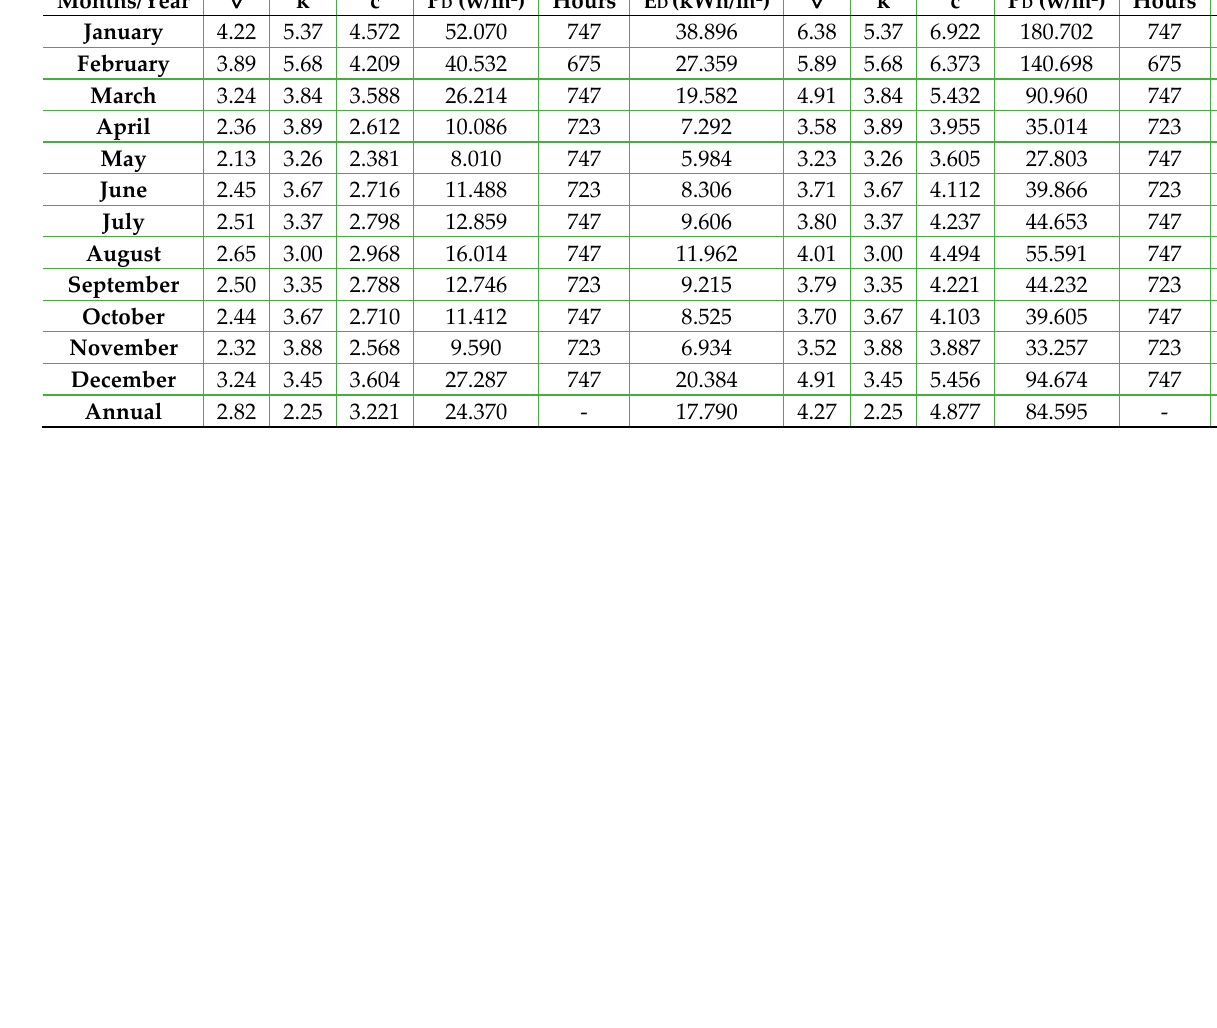
Table 3. Wind power and energy density characteristics at heights of 43.6 m and 100 m in Mersing. A Height of 43.6